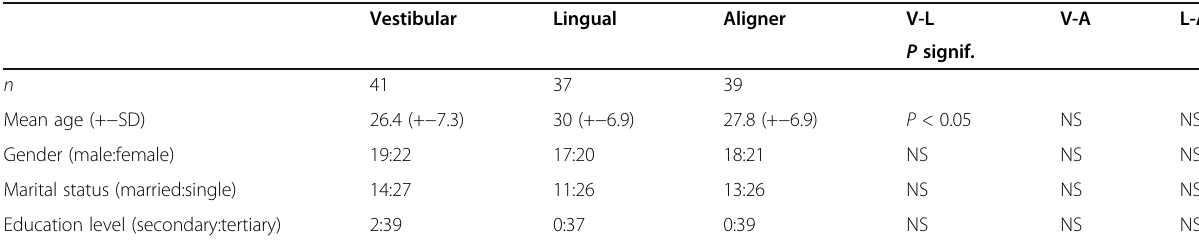
Table 1 Pre-treatment variables